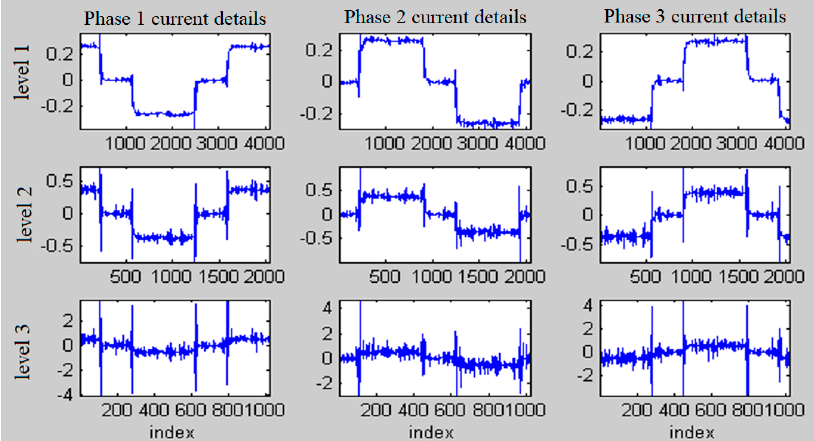
Figure 14. Vectors of details for currents, levels 1–3, first case study.